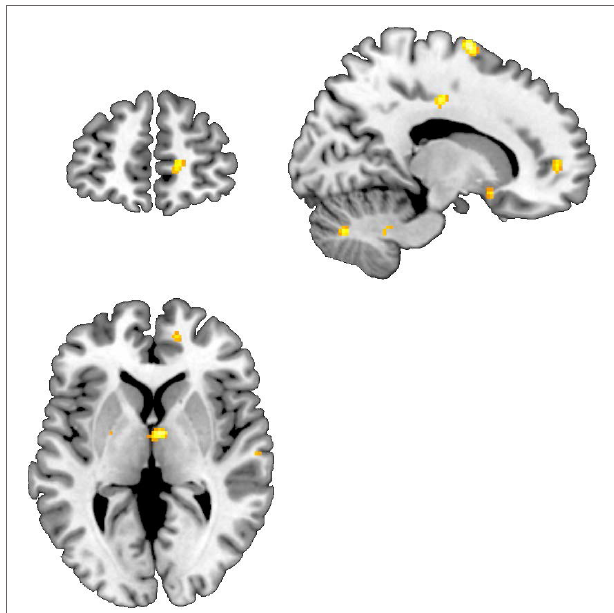
FigUre 2 | Areas of increased activation when viewing traumatic pictures, and sounds vs. neutral pictures and sounds, Mindfulness-based stress reduction > traditional supportive therapy. Increased activations in anterior cingulate, and subcallosal